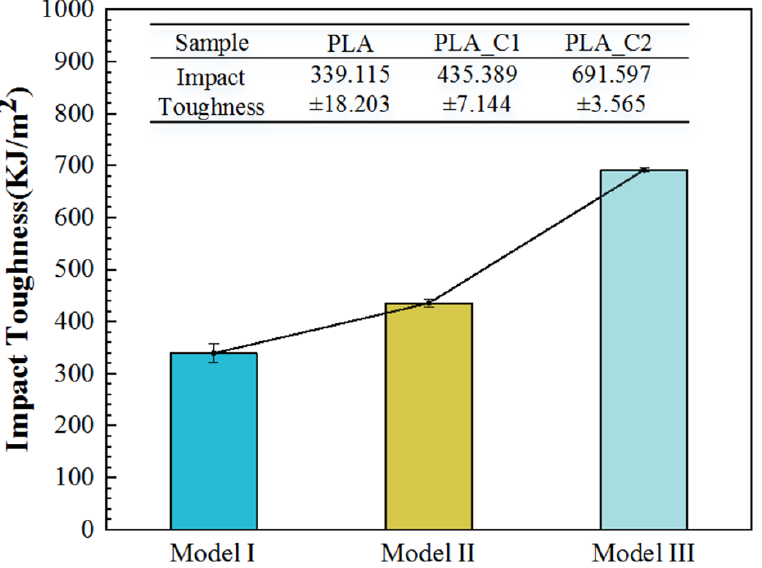
Figure 4. The impact toughness of Model I, Model II, Model III.